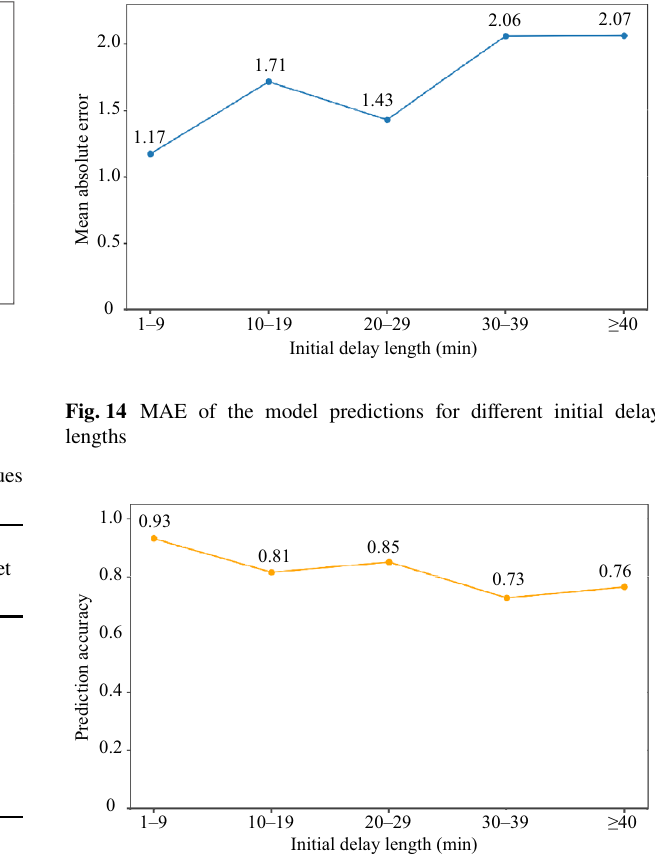
Table 7 MAE of the model predictions for different kinds of causal classifications Causal classification